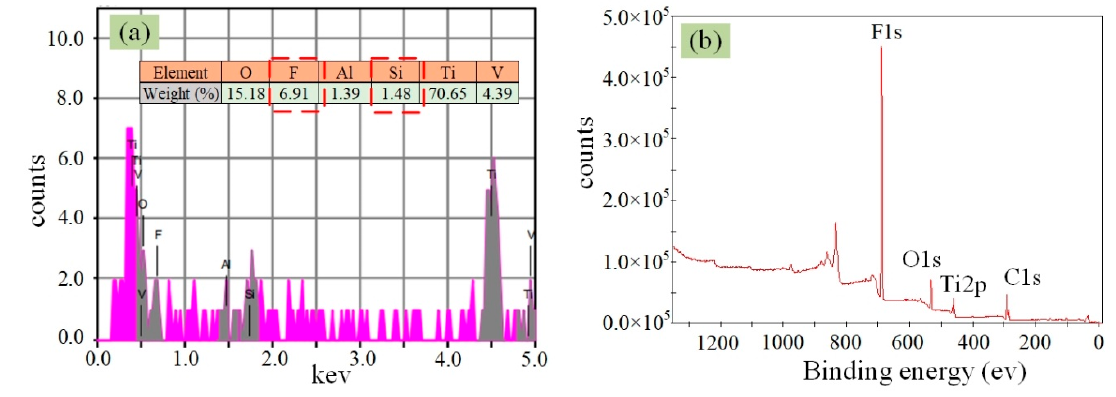
Figure 12. ( a ) EDS and ( b ) XPS spectra of the Ti–6Al–4V surface after silanization.